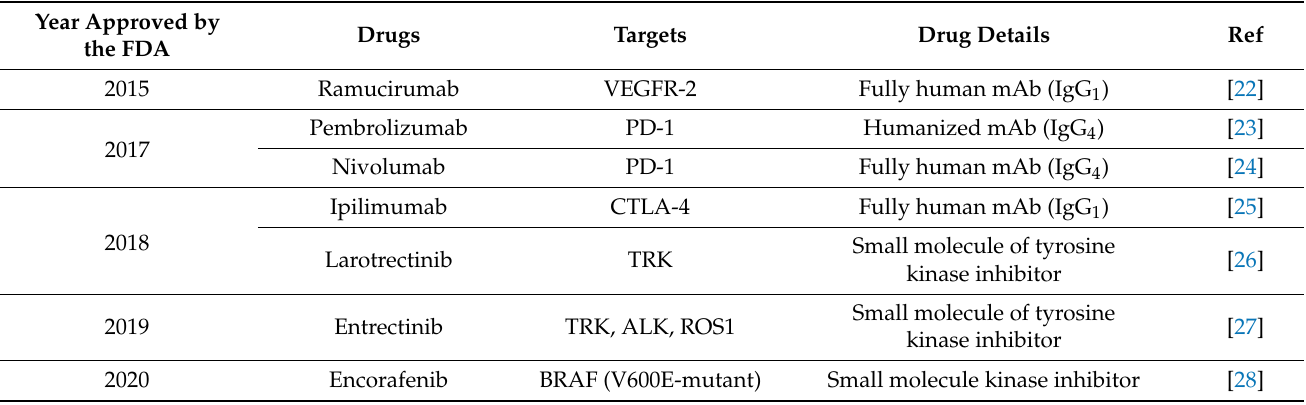
Abbreviations: EGFR: epidermal growth factor receptor; VEGF: vascular endothelial growth factor; PlGF: placenta growth factor; VEGFR: vascular endothelia growth factor receptor; FGFR: fibroblast growth factor receptor; KIT: mast/stem cell growth factor receptor; PDGFR: platelet-derived growth factor receptor; BRAF: v-Raf murine sarcoma viral oncogene homolog B1; PD-1: programmed cell death 1; CTLA-4: cytotoxic T-lymphocyte-associated protein-4; TRK: tropomyosin receptor kinase; ALK: anaplastic lymphoma kinase; ROS1: c-ros oncogene 1; mAb: monoclonal antibody. The progression and spread of mCRC involves mediation with receptors in several signaling pathways. These include EGFRs, fibroblast growth factor receptors (FGFRs), vascular endothelia growth factor receptors (VEGFRs), and tropomyosin receptor kinases (TRKs) [29,30]. Furthermore, tumor cells express B7-1 (CD80)/B7-2 (CD80) and programmed cell death ligand 1 (PD-L1), which bind to cytotoxic T-lymphocyte-associated protein-4 (CTLA-4) and programmed cell death 1 (PD-1), respectively, on T cells to escape immune surveillance [30]. Therefore, these molecules and their related pathways must be inhibited by targeted drugs (Figure 1).